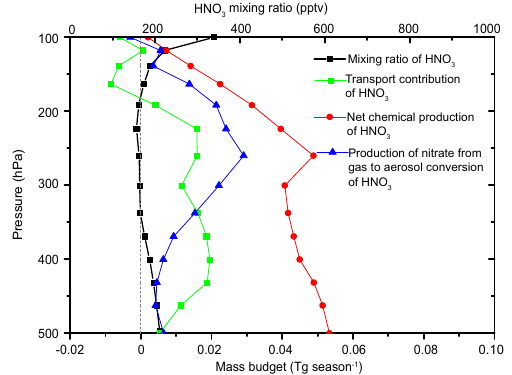
Figure 12. Profiles of the net chemical production of HNO 3 by gas-phase reactions and heterogeneous reactions (red dotted line), the production of nitrate from gas-to-aerosol conversion of HNO 3 (blue dotted line) and the transport contributions of HNO 3 over the TP/SASM (70–105 ◦ E, 10–40 ◦ N). The average HNO 3 mixing ra- tios (black dotted line) are also shown over the TP/SASM region during summertime of year